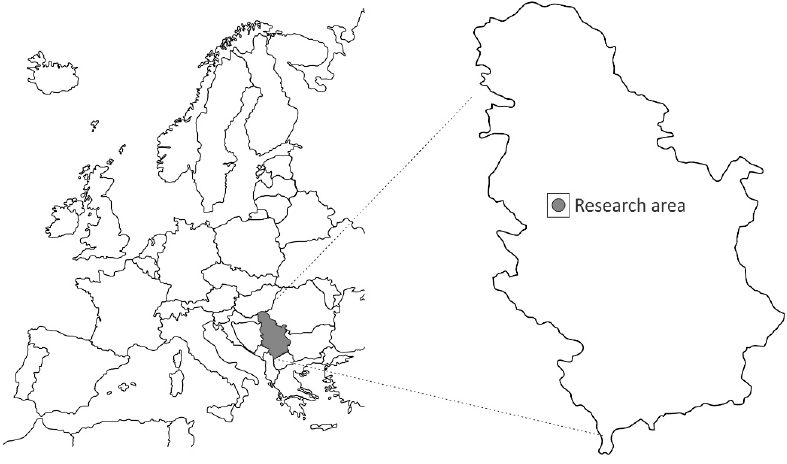
Figure 1. Location of the research area.